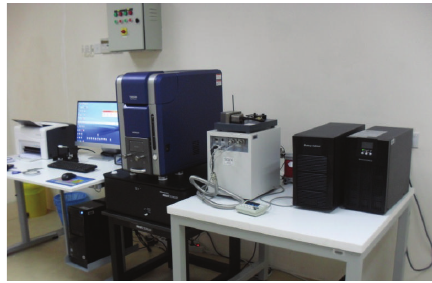
Figure 3: Instron universal testing machine used for compression test.